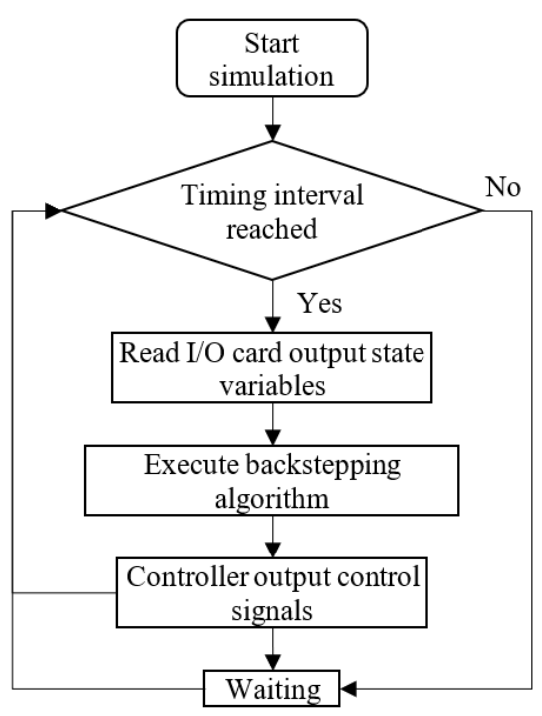
Figure 8. The flow chart of the control algorithm implementation of the controller. Combining the above hardware and software, a physical prototype of the HIL simula- tion system was built and is shown in Figure 9.